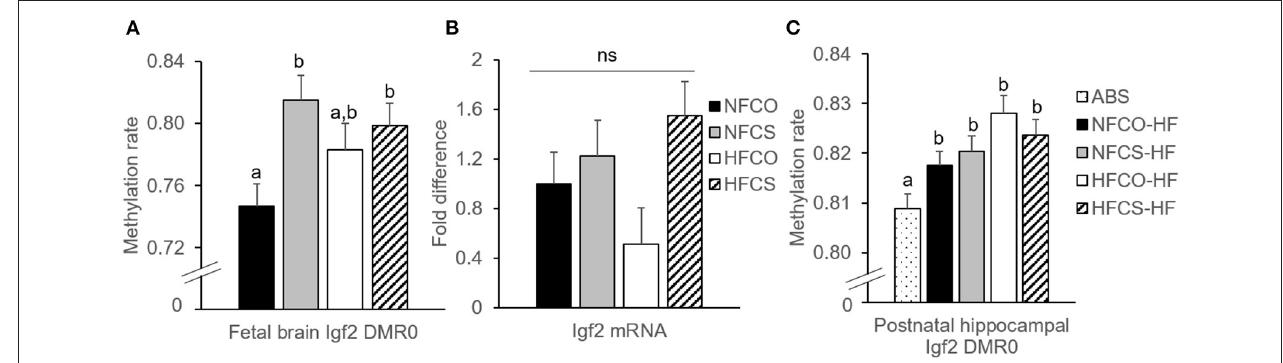
FIGURE 4 | Brain Igf2 differentially methylated region (DMR) 0 DNA methylation of mouse offspring with different maternal diets at E17.5 and after 6-week post-weaning high-fat feeding. (A) DMR0 methylation at E17.5. (B) Igf2 mRNA expression at E17.5. (C) Hippocampal Igf2 DMR0 methylation after post-weaning high-fat feeding. Different letters (e.g., a, b) represent statistically significant difference, p < 0.05; ns represents no significant difference. n = 6–8 per sex per group. ABS, absolute control; CO, control without choline supplement; CS, choline supplemented; HF, high-fat; NF,